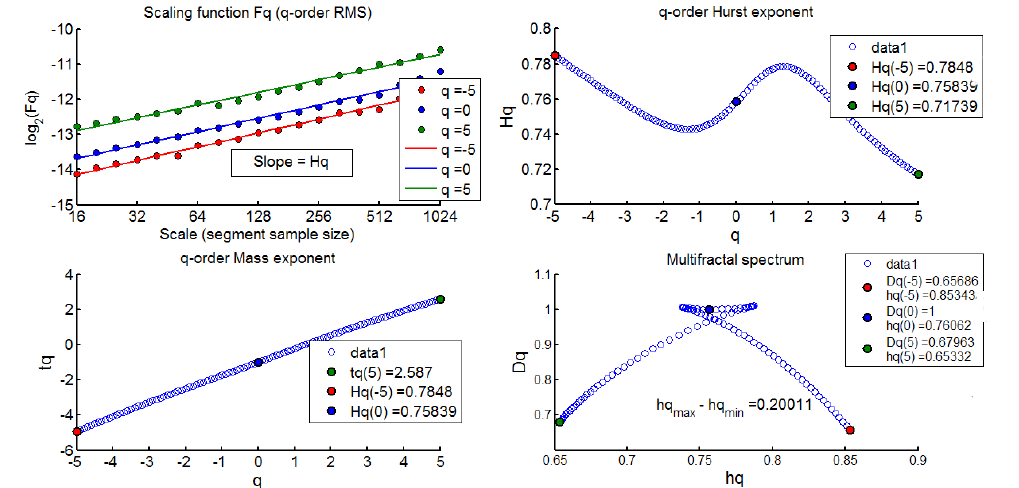
(5) of Nifty Pharma index on June 17, 2020, i.e., ( t = Figure 9. The H q